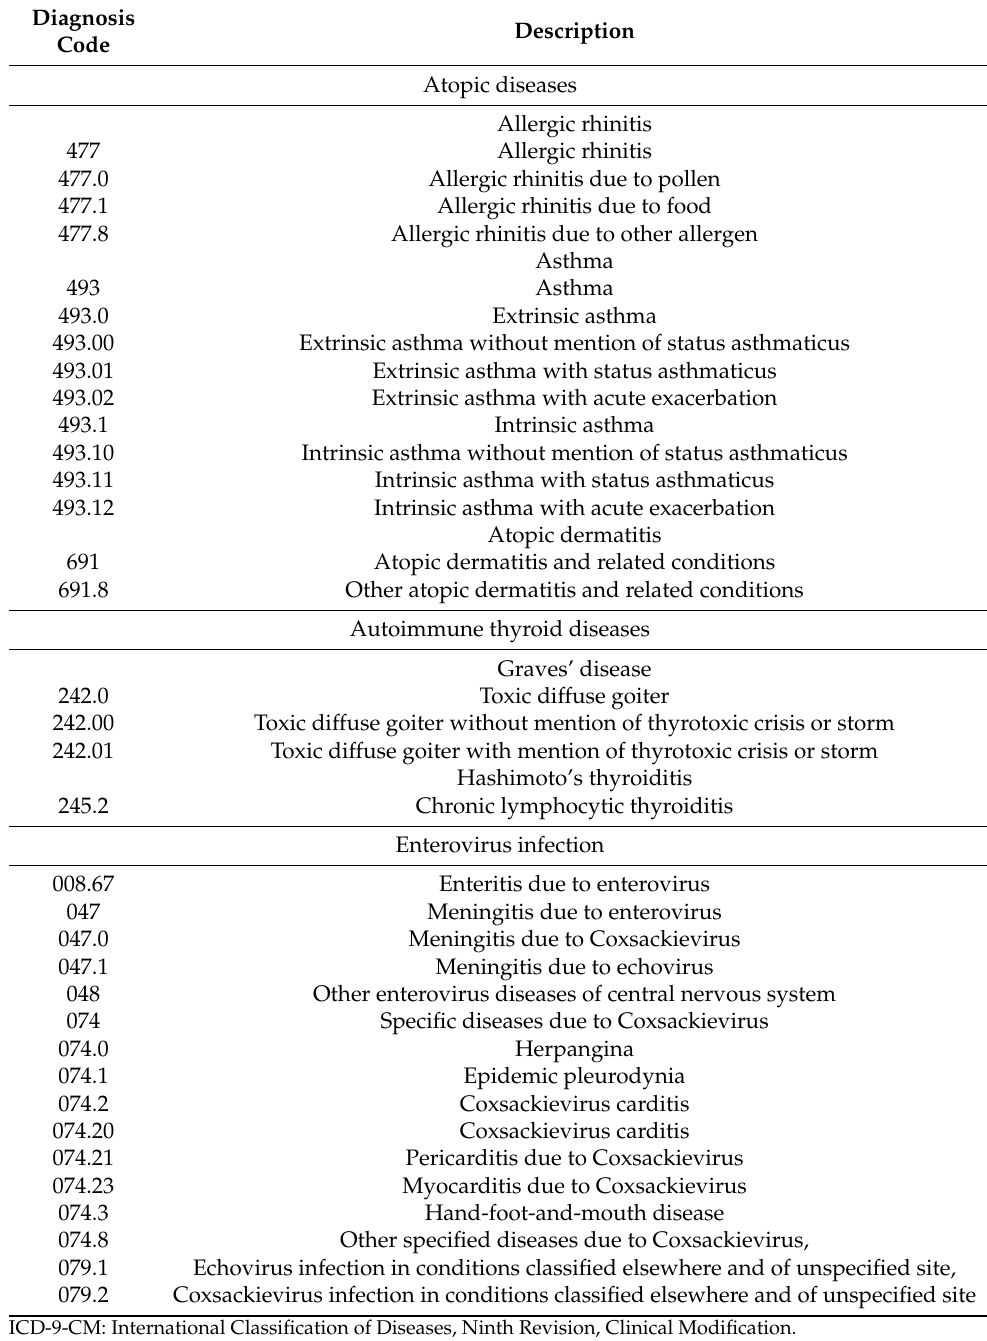
Table A3. ICD-9-CM codes used to identify